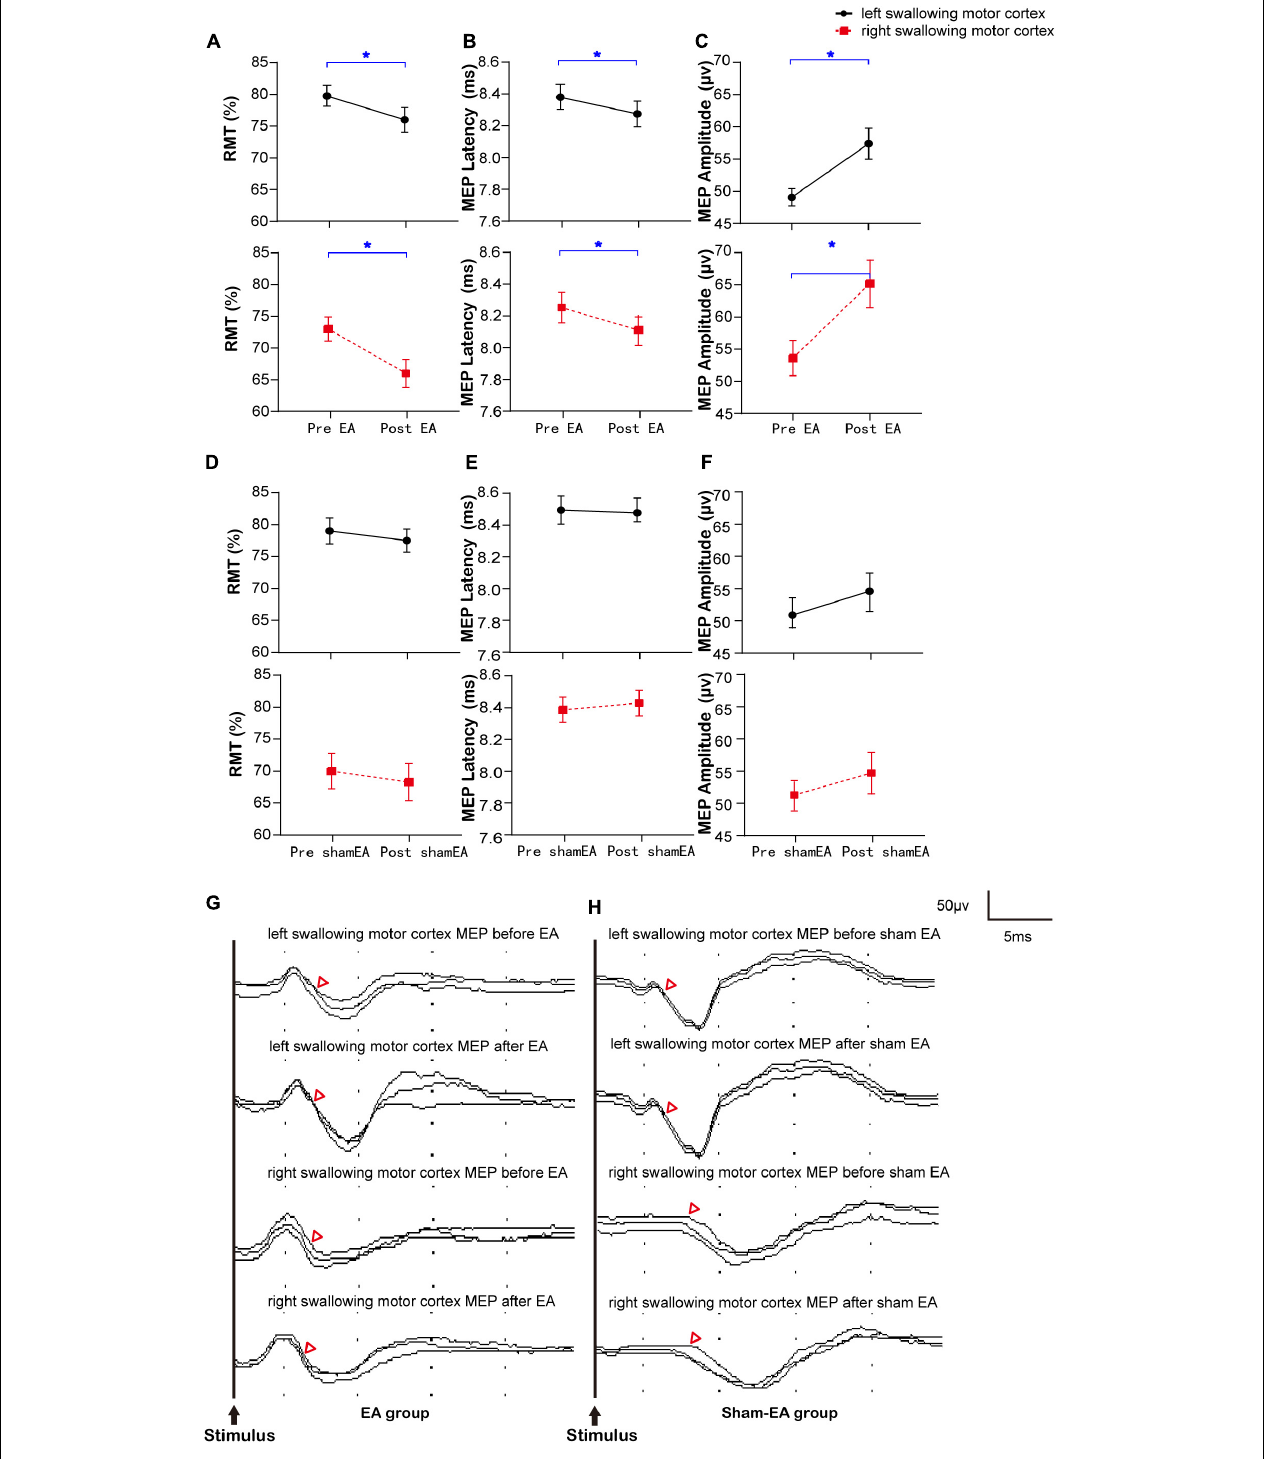
FIGURE 2 | Bilateral RMT and MEP of the swallowing motor cortex before and after the intervention and representative MEP. (A–C) The RMT and MEP of the cerebral swallowing motor cortex before and after EA. (D–F) The RMT and MEP of the cerebral swallowing motor cortex before and after sham-EA. (G,H) Representative EMG from the bilateral swallowing motor cortices before and after the intervention. RMT, resting motor threshold; MEP, motor evoked potential; EA, electro-acupuncture; * P < 0.05; (cid:77) represents the latency of motor evoked potential.